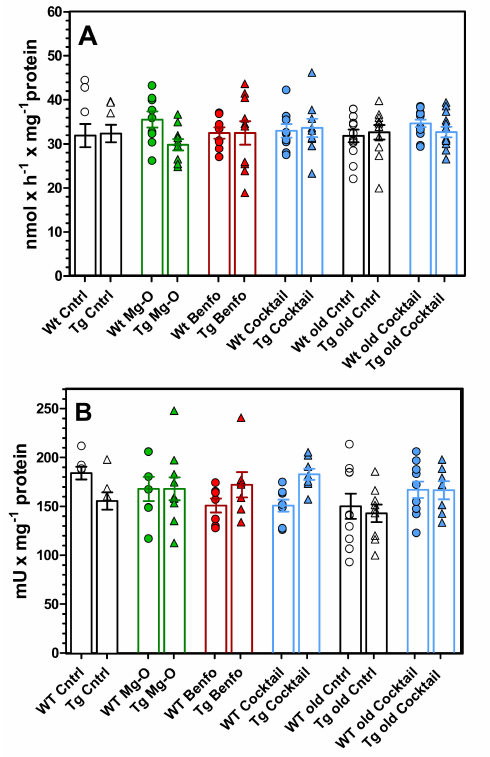
Figure 13. Enzyme activities of ( A ) choline acetyltransferase (ChAT) and ( B ) acetylcholinesterase (AChE) normalised to protein content. Data are means ± SEM ( n = 7–9) and were analysed by one-way ANOVA. ( A ) ChAT: F11,120 = 0.71, p = 0.73; ( B ) AChE: F11,96 = 1.76, p =